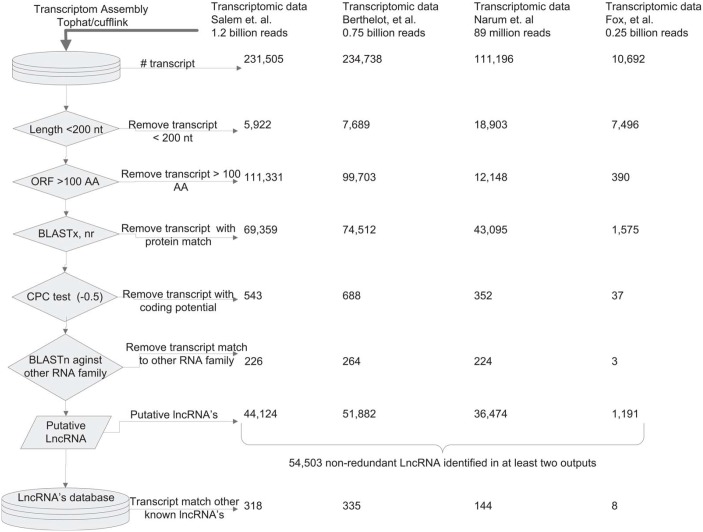
Bioinformatics pipeline used in prediction of rainbow trout lncRNAs.LncRNAs were predicted from four different transcriptomic datasets, then all putative lncRNAs from all data were blasted against each other. A total of 54,503 non-redundant lncRNAs identified in at least 2 of the 4 data sets were chosen for further analyses in order to increase the confidence of lncRNA prediction. Vertical arrows are pointing toward the subsequent prediction and filtration steps of the workflow. First horizontal arrow pointing toward the right is referring to the number of initial transcripts predicted from the four datasets. Middle six horizontal arrows indicate the number of transcripts filtered at each step and the final horizontal arrow points to the number of putative lncRNAs with significant hits to noncoding-RNA databases from each dataset.